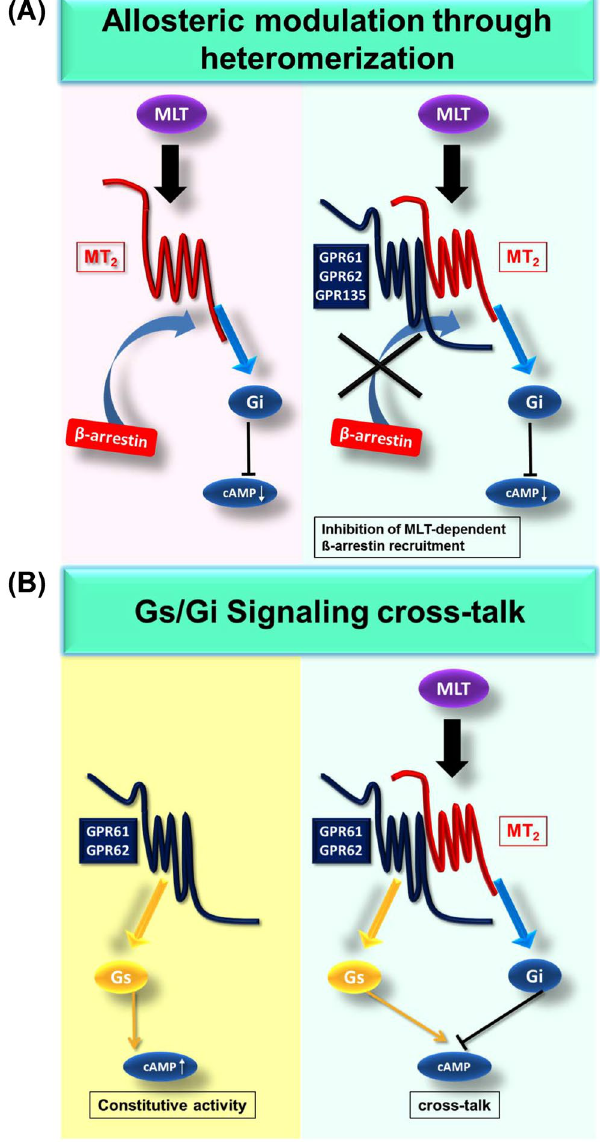
Figure 8. Schematic representation of the reciprocal interaction between MT 2 receptors and orphan GPR61, GPR62 and GPR135 receptors. ( A ) Proposed model of pathway-biased allosteric modulation of MT 2 function in heteromers with orphan GPR61, GPR62 and GPR135 receptors. In the presence of GPR61, GPR62 and GPR135, melatonin-induced ß-arrestin recruitment is decreased and G i/o signaling is unaffected. ( B ) G protein signaling cross-talk between MT 2 and GPR61 or GPR62. Constitutively active GPR61 and GPR62 stimulate cAMP production whereas melatonin stimulation of MT 2 decreases cAMP